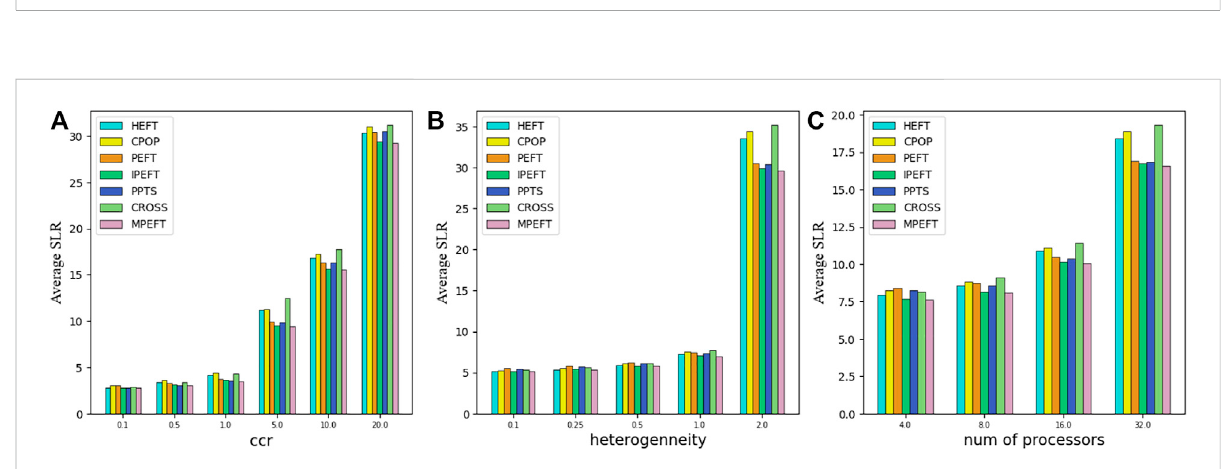
FIGURE 10 Average SLR as function of ccr (A) , heterogeneity (B) and number of processors (C) for Ligo Work fl ows.